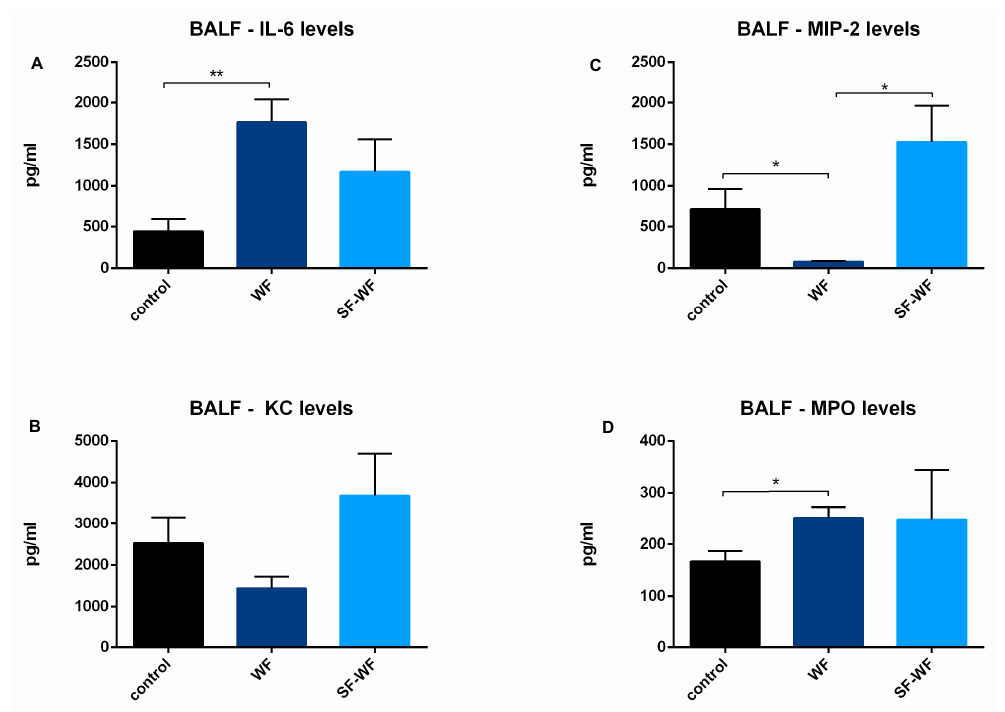
Figure 3. Influence of welding fume instillation: Cytokine release of isolated perfused lungs into BALF. ( A ): IL-6 levels in BALF (mean ± SEM), ( B ): KC levels in BALF (mean ± SEM), ( C ): MIP-2 levels in BALF (mean ± SEM), ( D ): MPO levels in BALF (mean ± SEM.). * = p < 0.05, ** = p < 0.01, control and WF n = 6, SF-WF n = 5.